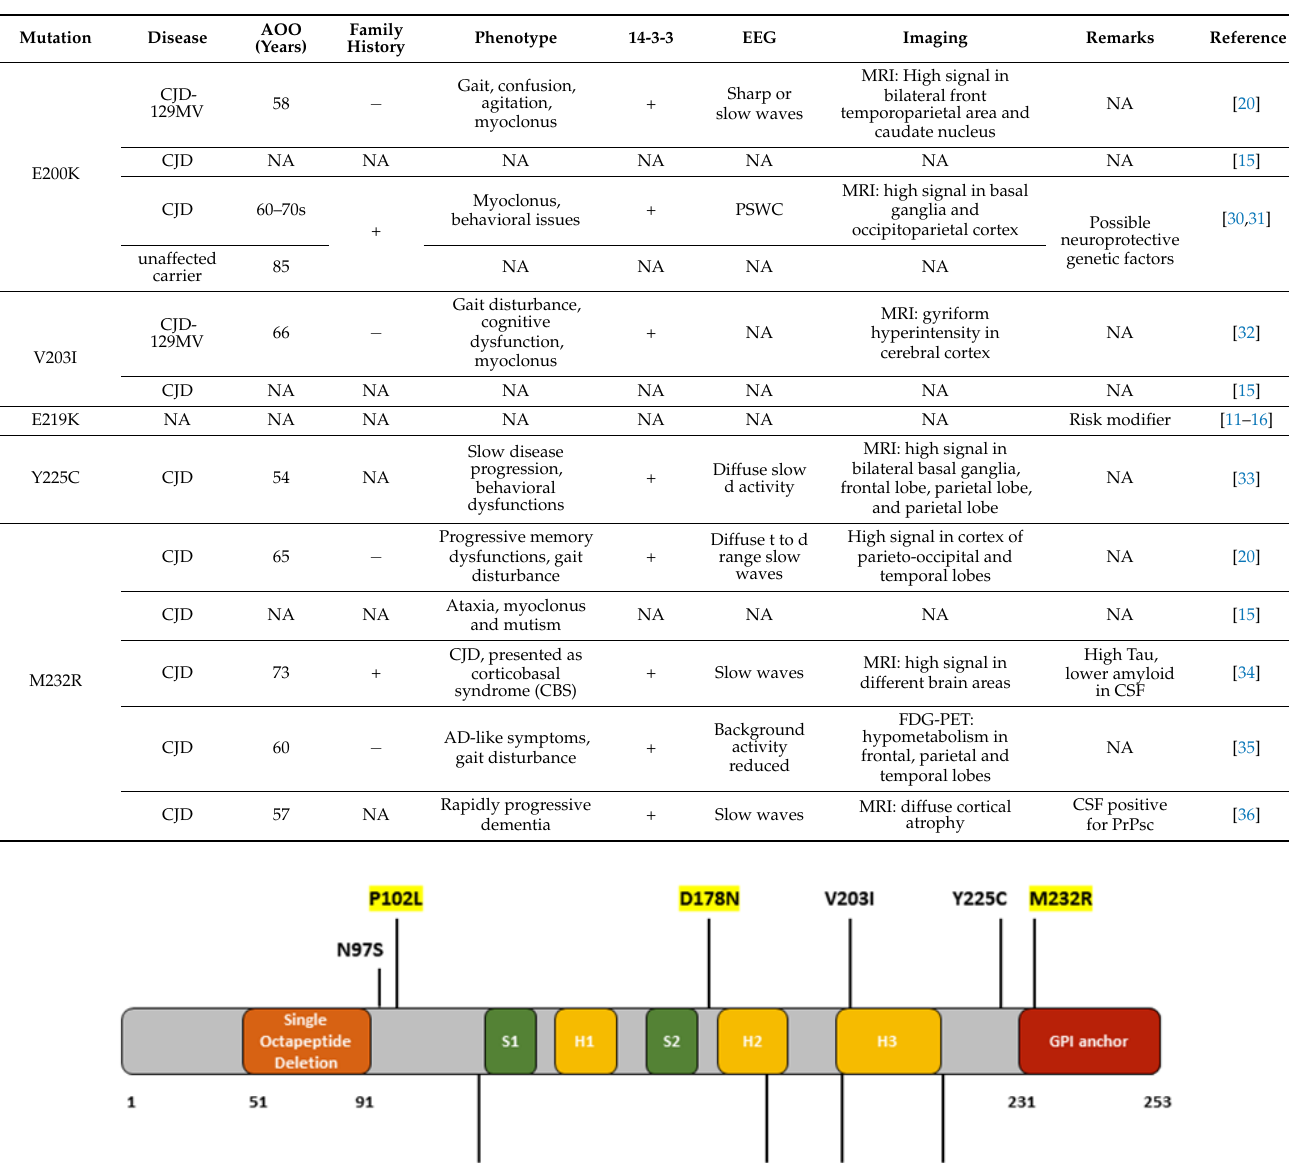
MRI: hyperintensities in right different brain areas, no atrophy